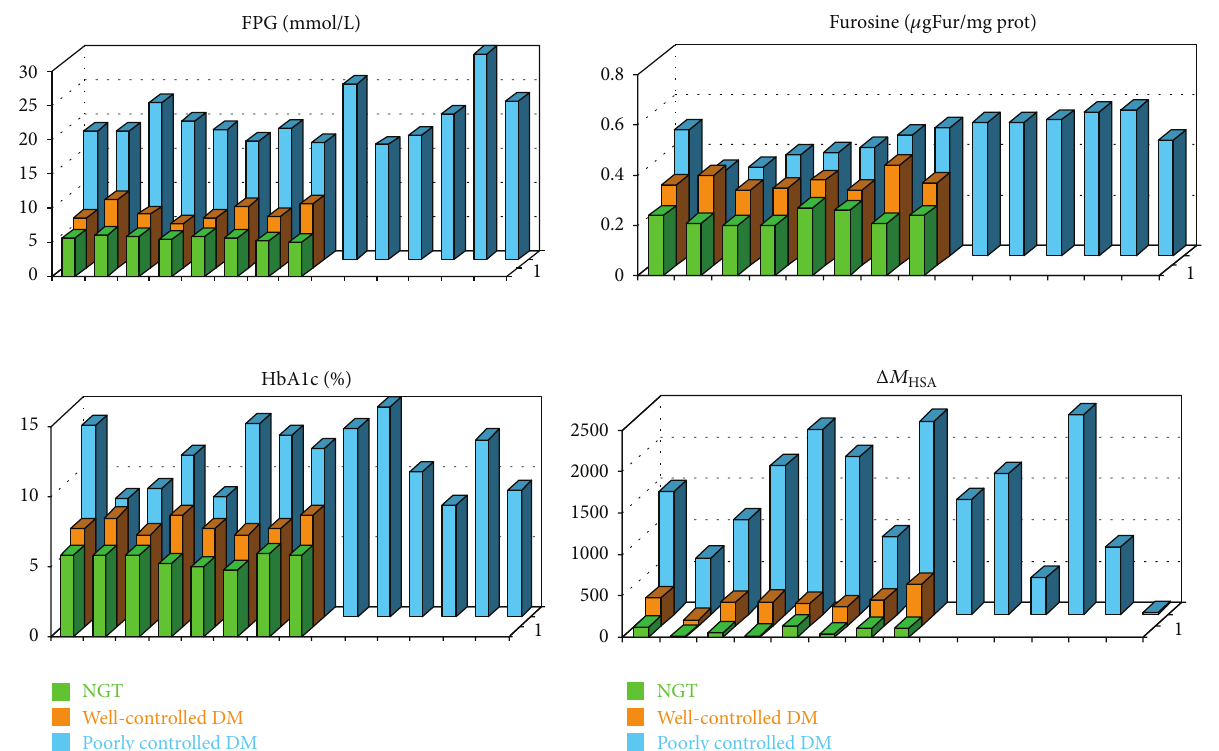
Figure 2: Fasting plasma glucose (FPG), furosine, HbA1c levels, and HSA Δ𝑀 values obtained for healthy subjects (first line), well-controlled diabetic patients (second line), and poorly controlled diabetic patients (third line).